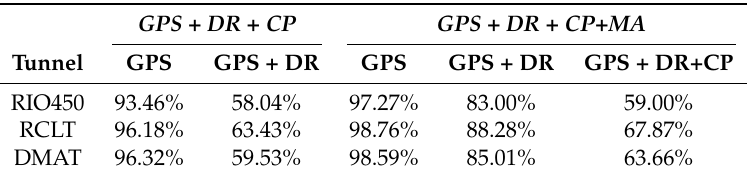
Figure 13. Different percentages of time of GPS unavailability for each evaluated scenario. Table 6. Average gains for GPS + DR (Dead Reckoning) + CP (Cooperative Positioning) and GPS + DR + CP + MA (Map